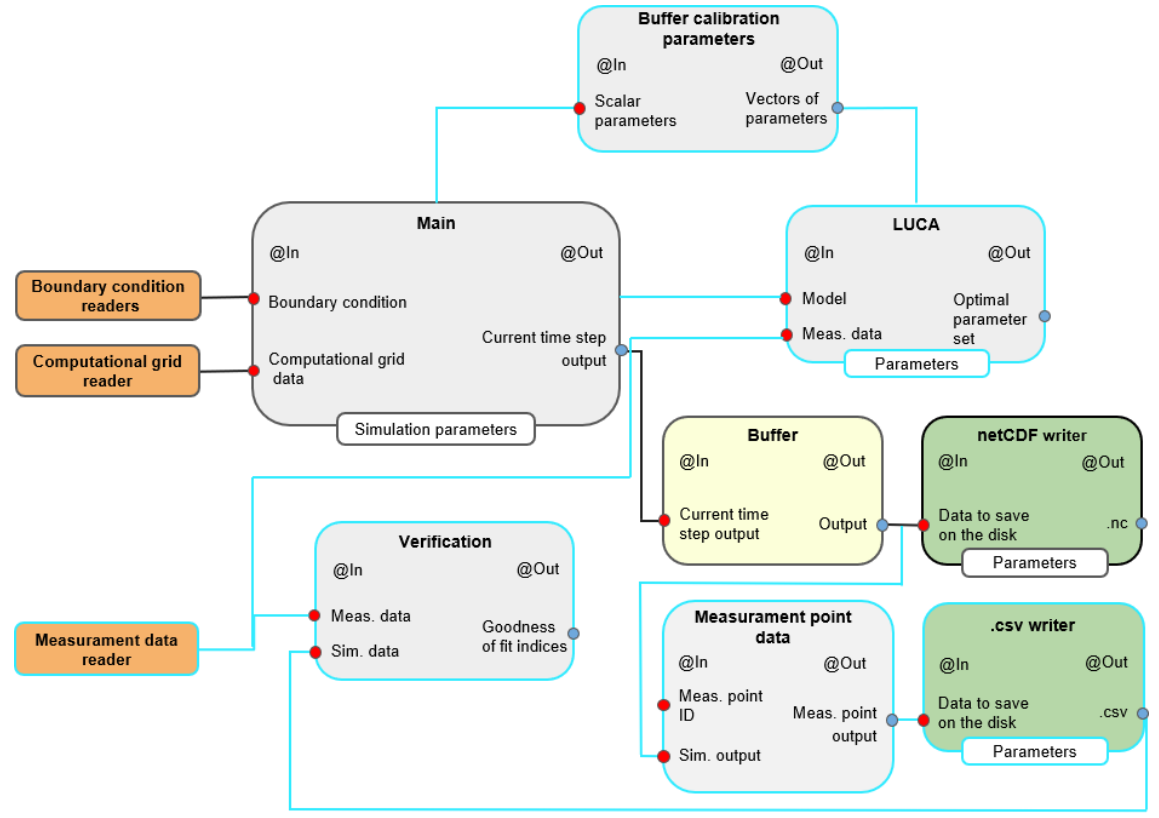
Figure 9. Workflow of WHETGEO-1D integrated with LUCA . The cyan lines identify components required to integrate WHETGEO-1D with LUCA . The LUCA and Verification components are built-in OMS3 components. The former is used to calibrate optimal pa- rameters and the latter to compute the indices of goodness of simulated data versus measured data. To integrate WHETGEO-1D with the OMS3 calibration components it is necessary to add two other components into the workflow, specifically the Buffer calibration parameters component and the Measurement points data component. LUCA handles scalar parameters, whilst WHETGEO-1D uses vectorial parameters. Buffer calibration parameters creates an interface between these two components, simply creating vectorial parameters from scalar parameters. The Verification component requires the input time series as a .csv file of simulated data at the measurement points. To accomplish this requirement, it is necessary to modify the output strategy: the Buffer component passes output data to the Measurement points data component. This component extracts only the simulated variables at the measurement points and passes them to the OMS3 time series writer, .csv writer , which saves the simulated time series as a .csv file. Notably, if the user is not interested in saving all the output of each run of the model during calibration, it is possible to remove the netCDF writer